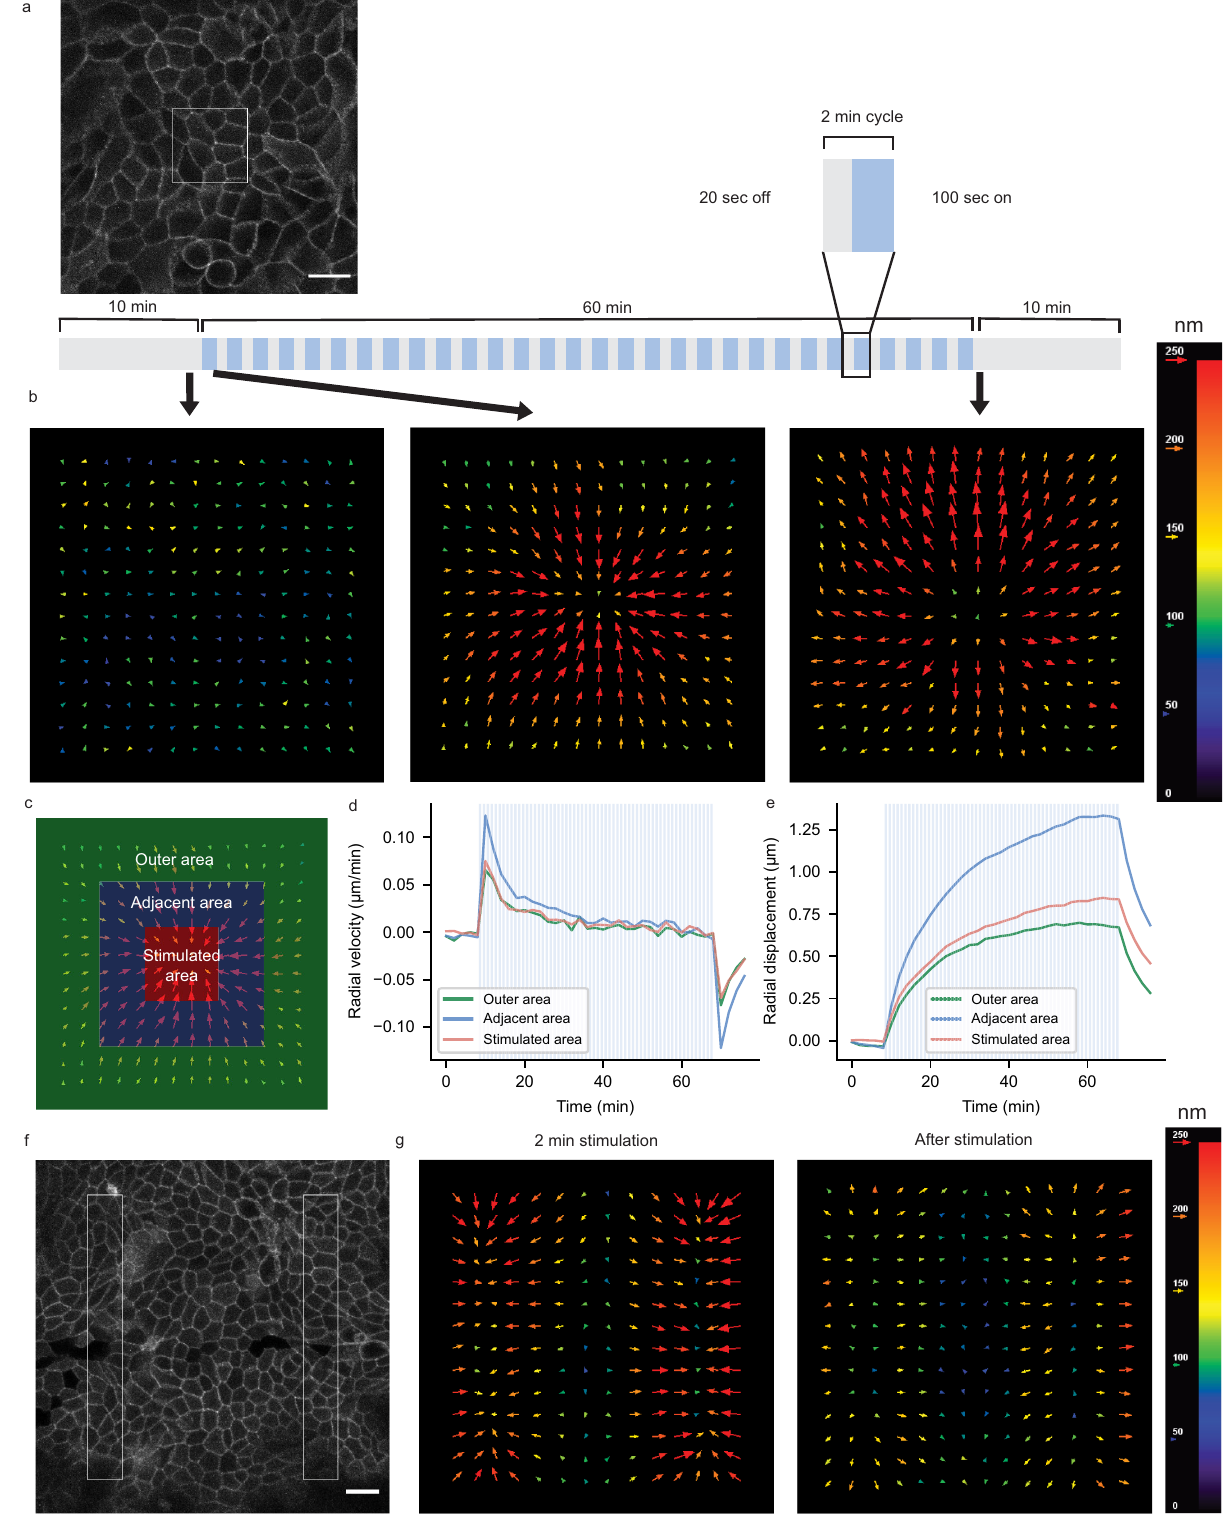
Fig. 3 | OptoShroom3-induced apical displacements on con fl uent monolayers. a Apical slice of iRFP-CAAX signal of MDCK cells on a thick collagen gel. The white boxmarksthestimulatedarea.Scalebar=20 μ m. b AveragedPIVanalysisonapical slices before, during (2min), and after stimulation in a 35.3×35.3 μ m area ( N =6). c Division of PIV frame in three areas for analysis, stimulated, adjacent, and outer areas. d Temporalevolutionofradialvectorcomponentsaveragedbyarea.Positive